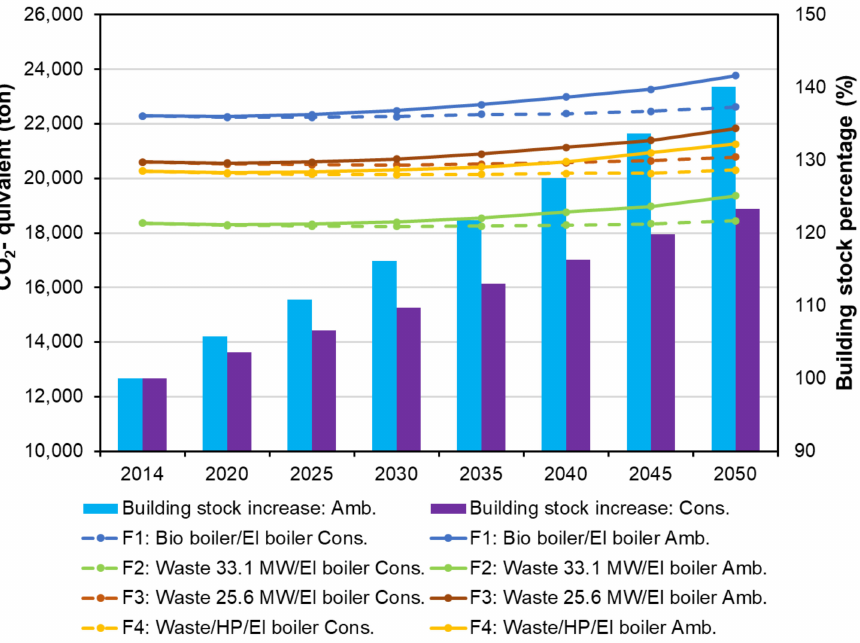
Figure 8. CO 2 emissions of the increased building stock considering different development